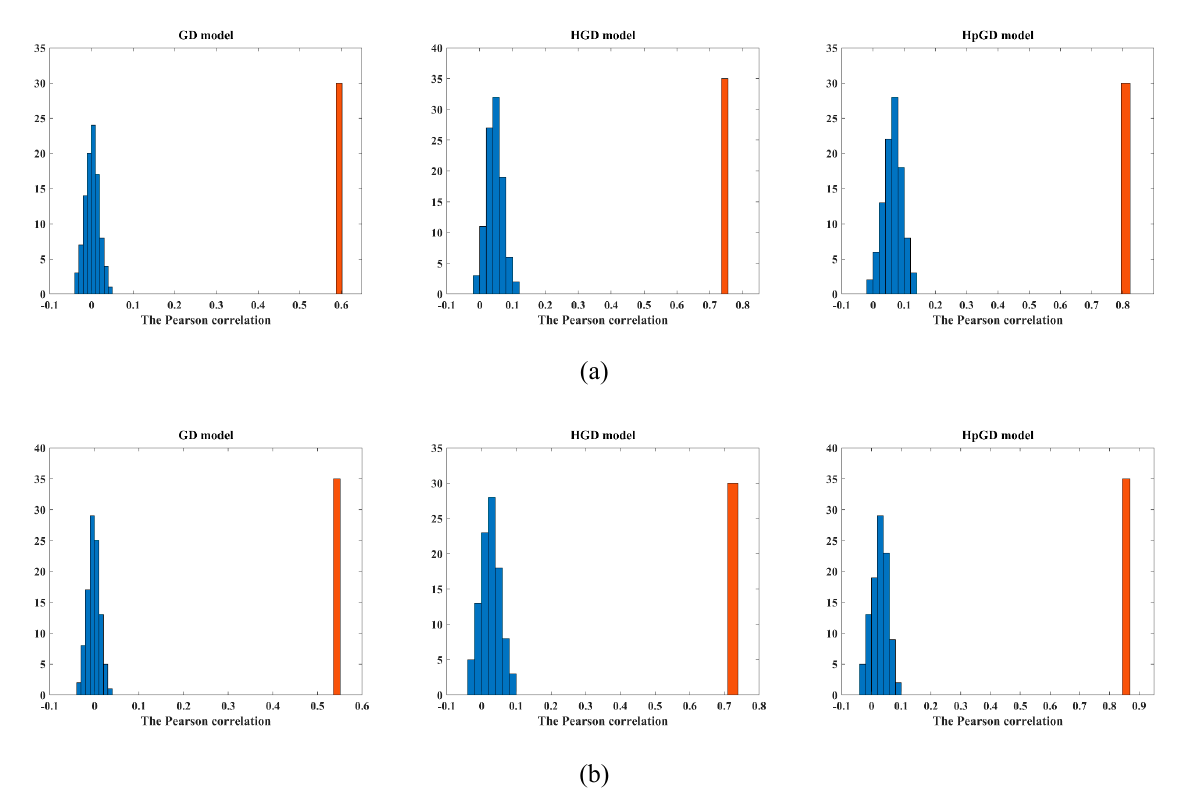
Figure 5. The histogram of the Pearson correlations with the three models. ( a ) The 90 ROIs dataset. ( b ) The 246 ROIs Fig. 5 The histogram of the Pearson correlations with the three models. (a) 90 ROIs dataset. (b) 246 ROIs dataset.